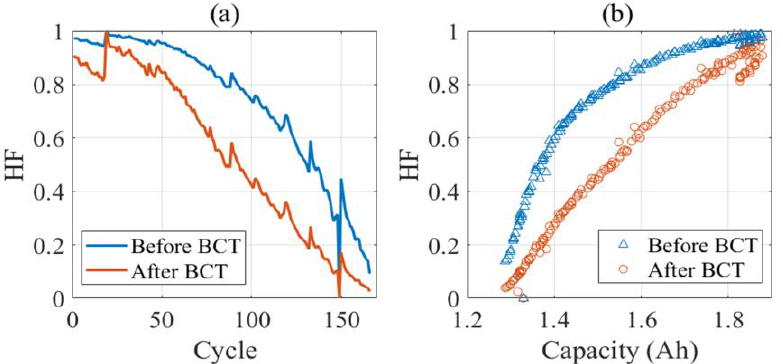
Figure 14. HF changes with ( a ) cycle and ( b ) capacity before and after BCT transformation.